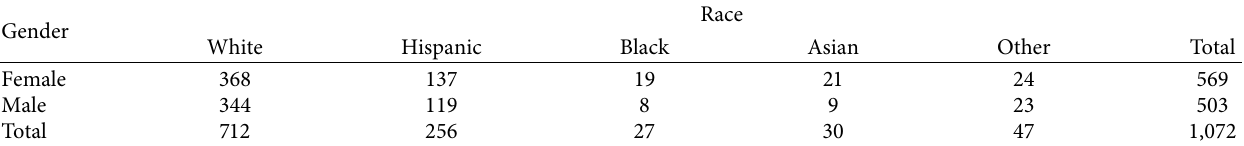
Table 1: Participants distributed by gender and race.